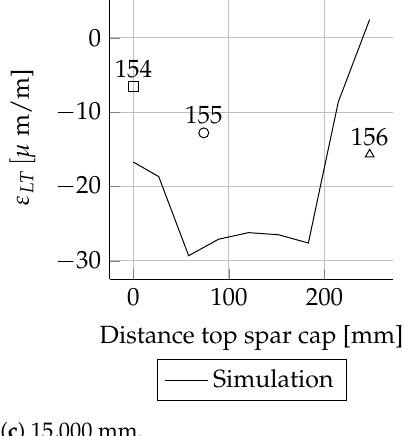
Figure A27. Spar at shear strains for MxMin load case.